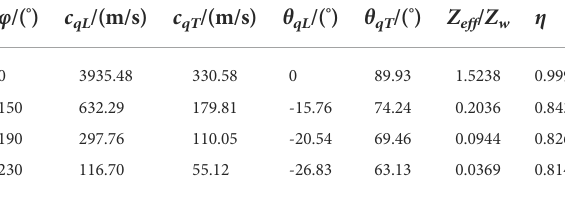
TABLE 2 Effective parameters of four